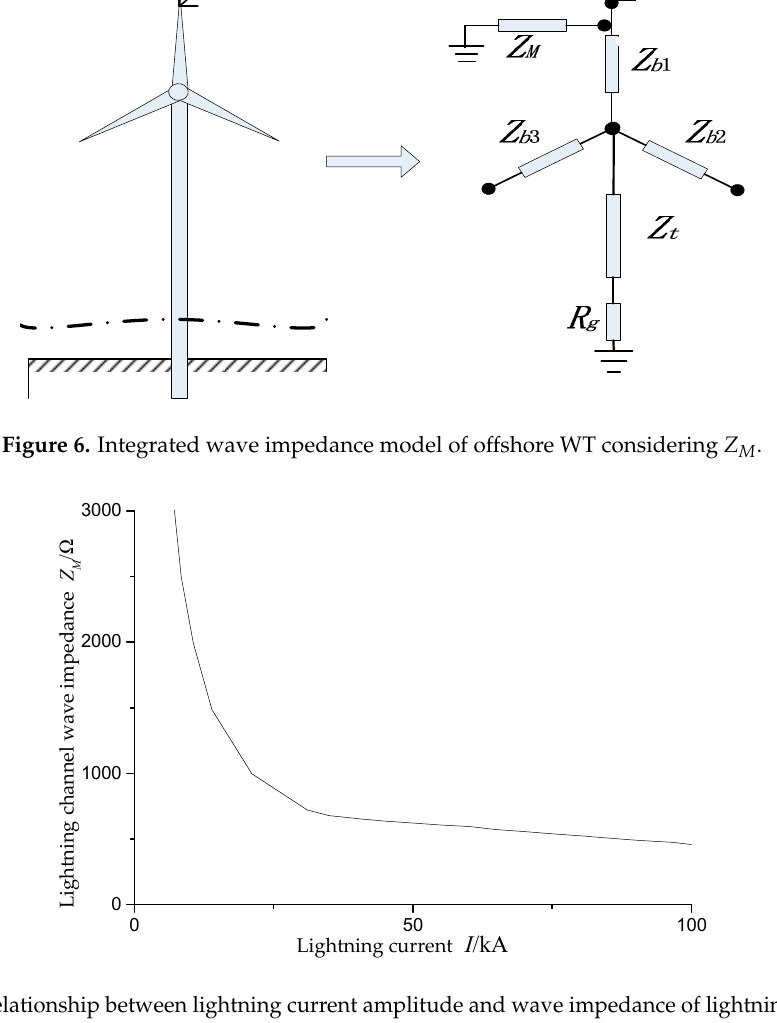
Figure 7. Relationship between lightning current amplitude and wave impedance of lightning channel.